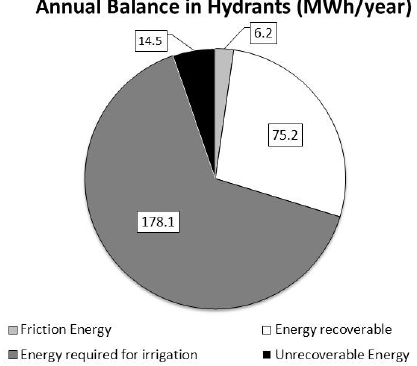
Figure 21. Annual Balance Energy in hydrants.